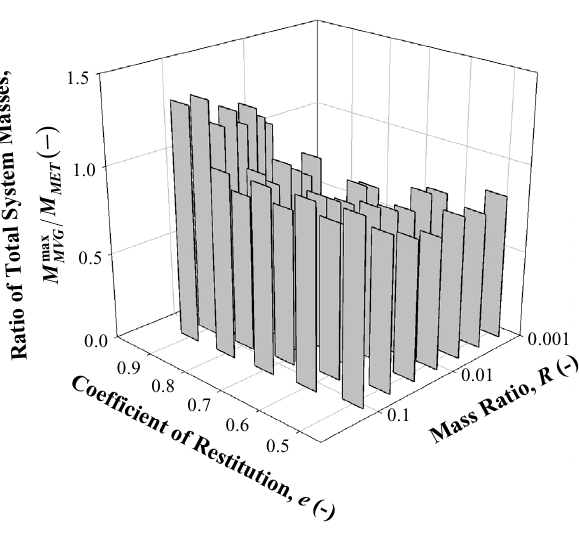
Fig. 15. 3D plot of ratio (MVG/MET) of total system masses versus coefficient of restitution and mass ratio. The total mass for the MVG system is that of the optimal MVG system for the given R,e . (-) means non-dimensional.